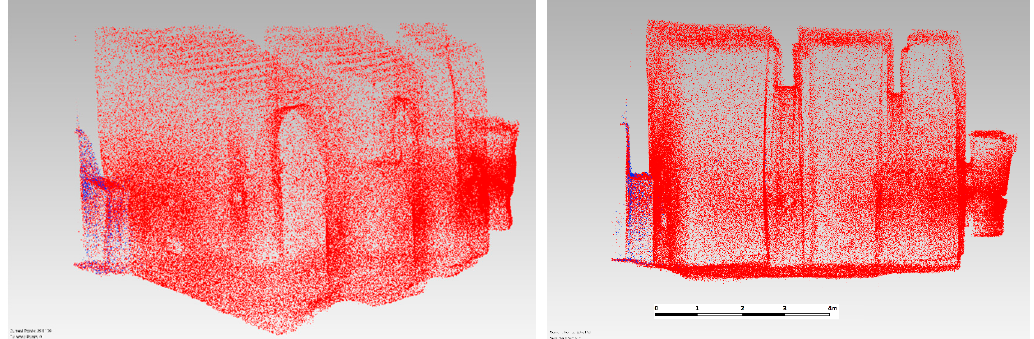
Figure 11. Point cloud from ZEB-REVO (a camera for texturing is not included in this model).